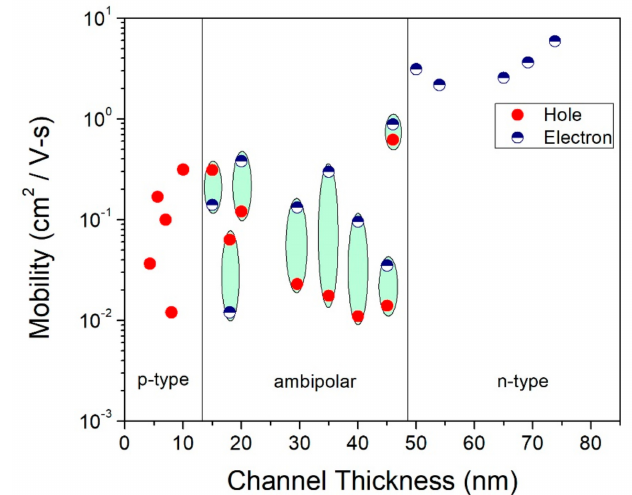
Figure 4. Field-e ff ect mobility of electrons and holes vs. channel thickness for MoTe 2 FETs. Encircled pairs of data points correspond to the ambipolar devices that exhibit ambipolar